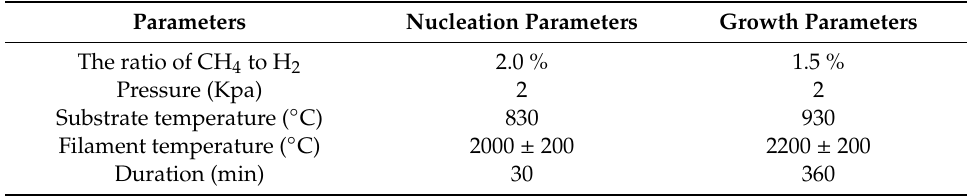
Table 2. The deposition parameters for diamond